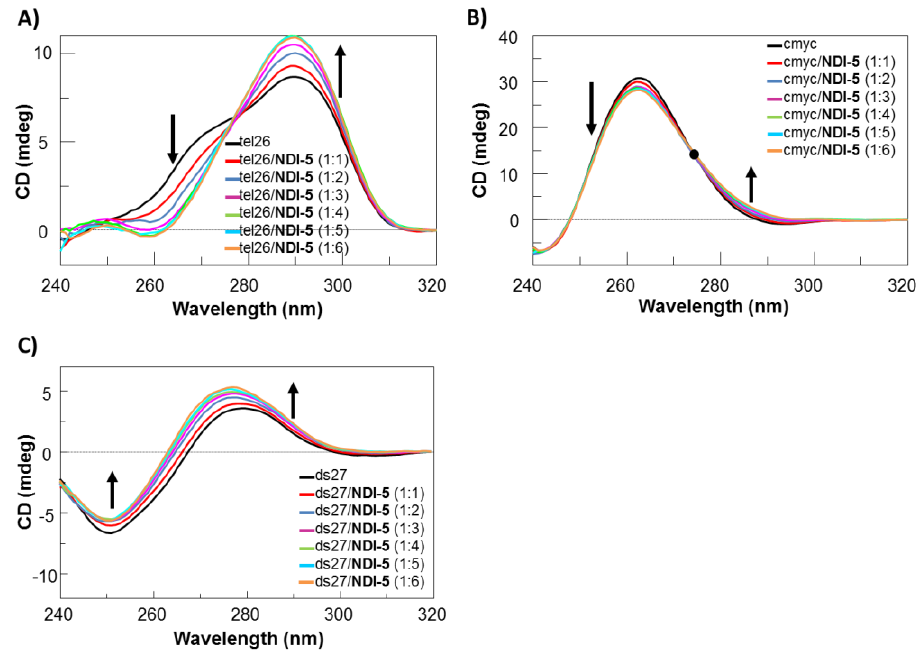
Figure 7. CD spectra of 2 µM solutions of ( A ) tel26, ( B ) cmyc and ( C ) ds27 in 20 mM KCl, 5 mM KH 2 PO 4 and 10% DMSO buffer (pH 7), in the absence and presence of increasing amount of NDI-5 (up to six equivalents). Isosbestic point in (B) is shown as black dot; black arrows indicate intensity variations of the specific bands going from 1:1 to 1:6 oligonucleotide/ NDI-5 ratio.